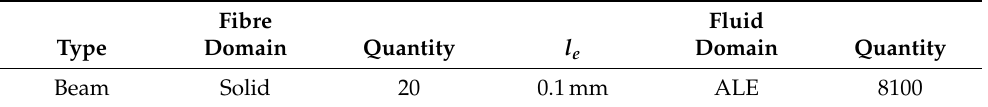
Table 9. Mesh characteristics of the validation model.